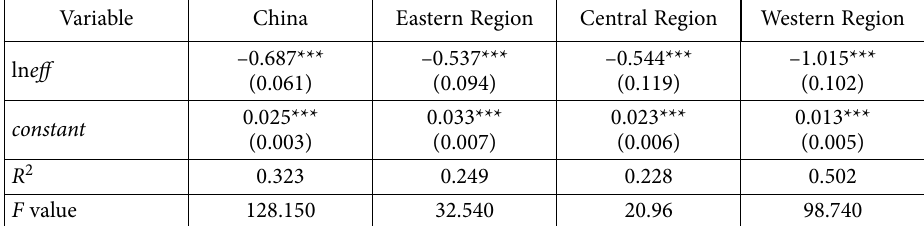
Table 2. Regression result of absolute convergence of environmental efficiency (source: The data in the table are calculated by the software of STATA) Variable